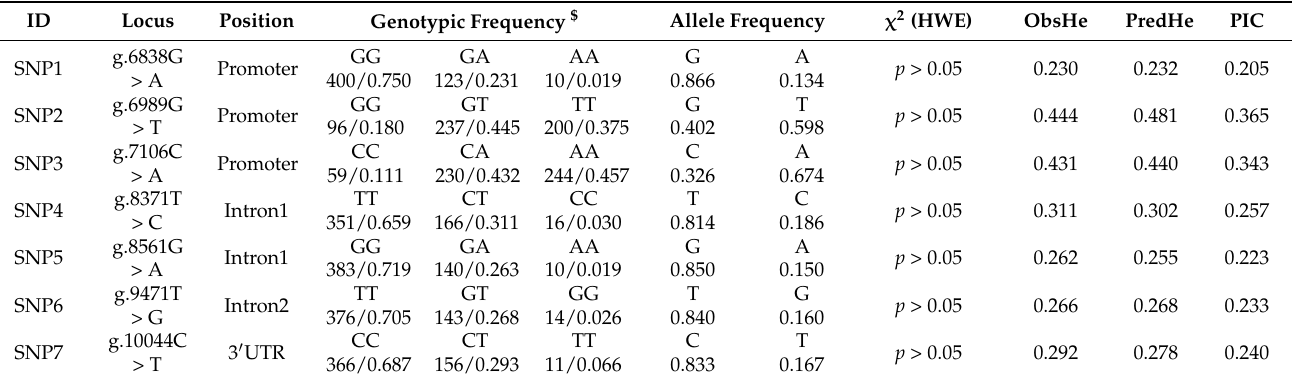
Table 1. Genetic parameters, genotypic, and allelic frequencies of MYF5 .